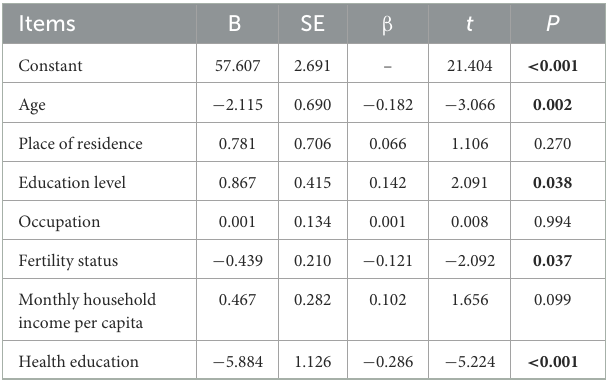
TABLE 4 Multiple linear regression of KT